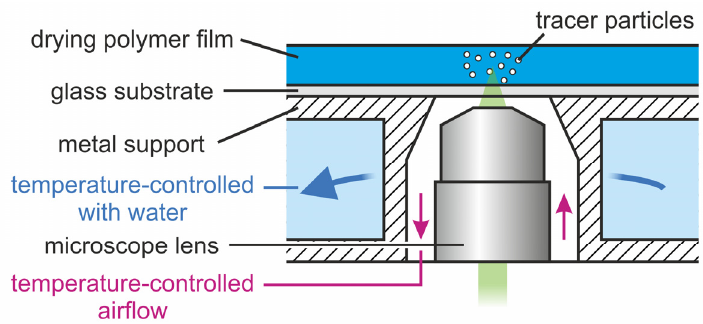
Figure 1. Schematic drawing of the substrate temperature control 3D-µPTV drying experiments.